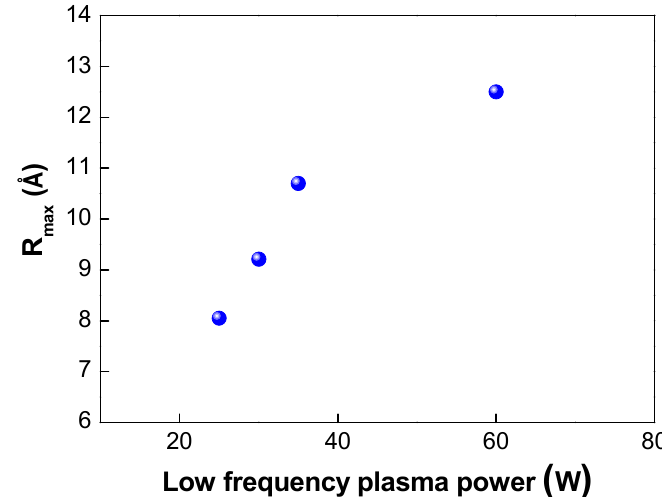
Figure 7. Changes in Rmax under different low plasma powers.